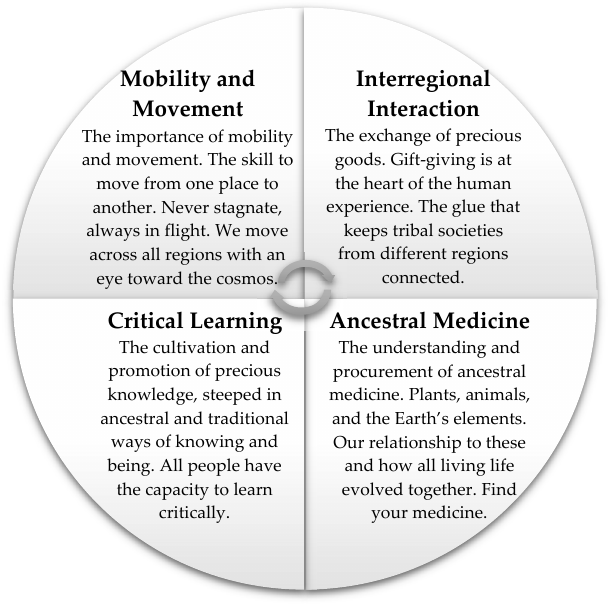
Figure 9. The Wheel of Quetzalcoatl revolves critical learning, mobility and movement, interregional interaction, and ancestral medicine. These stand for an array of teaching units (a familial place of belonging and practice) that cultivate positive health, learning, and community. The model is culturally relevant, encourages healing ways, and revitalizes and sustains the ancestral outside of the classroom.